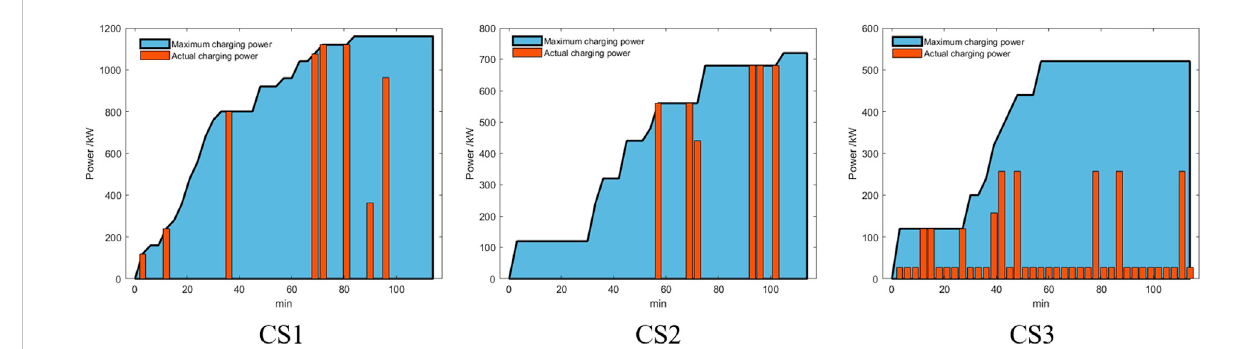
FIGURE 9 Charging power variation of charging stations.